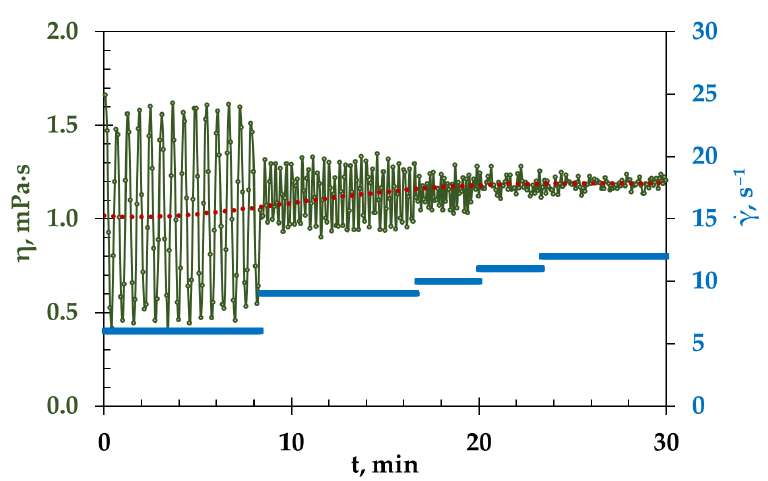
Figure 3. Viscosity of molten (LiF - NaF - KF) eut at different shear rates (blue lines) with a fixed measurement time for each point (5 s).